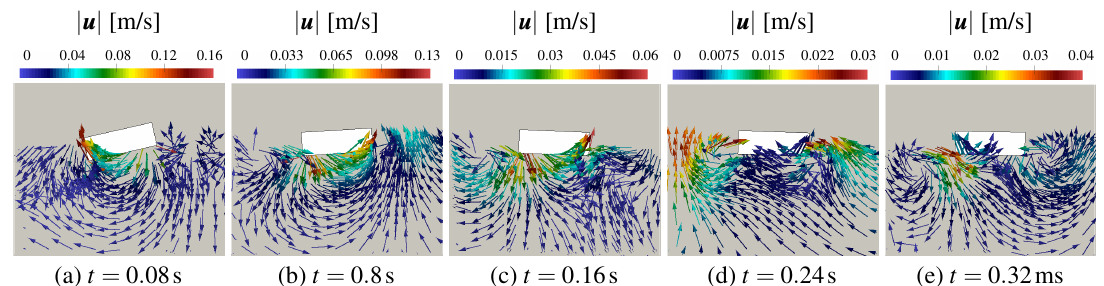
Figure 12. Representation of the flow field in the vicinity of the oscillating box for different times. For clarity, vectors are represented only in water. ( a ) t = 0.08 s, ( b ) t = 0.8 s, ( c ) t = 0.16 s, ( d ) t = 0.24 s and ( e ) t = 0.32